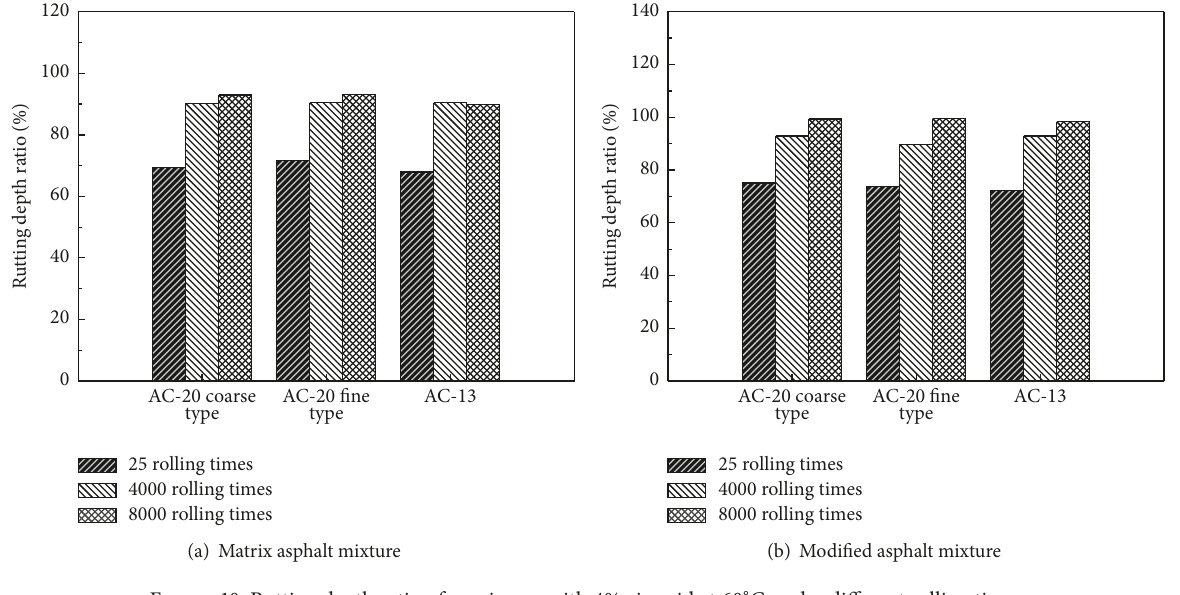
Figure 10: Rutting depth ratio of specimens with 4% air void at 60 ∘ C under different rolling times.